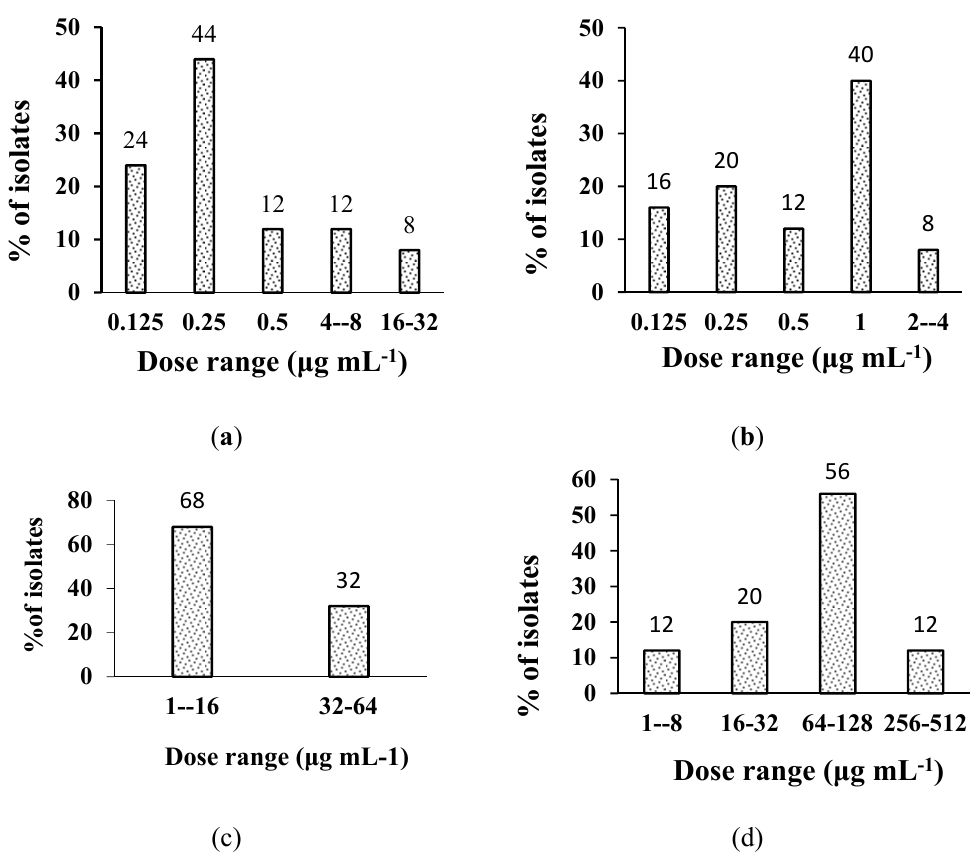
Figure 1. Effectiveness of ( a ) amoxicillin; ( b ) clarithromycin; ( c ) tetracycline; ( d ) metronidazole against clinical isolates of H. pylori